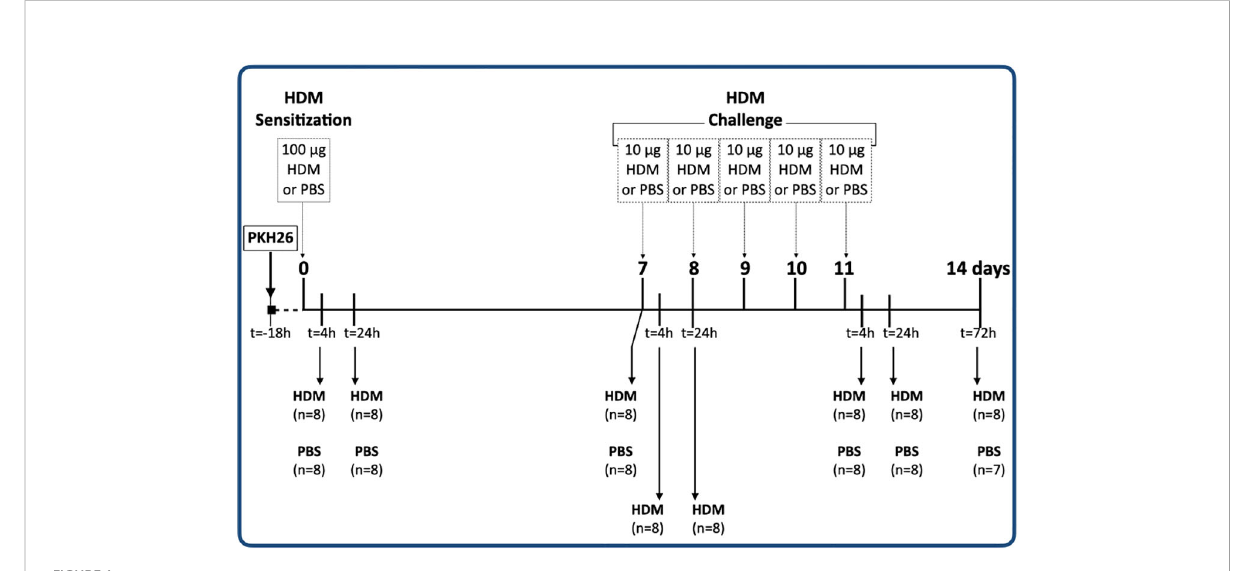
FIGURE 1 Experimental design of the